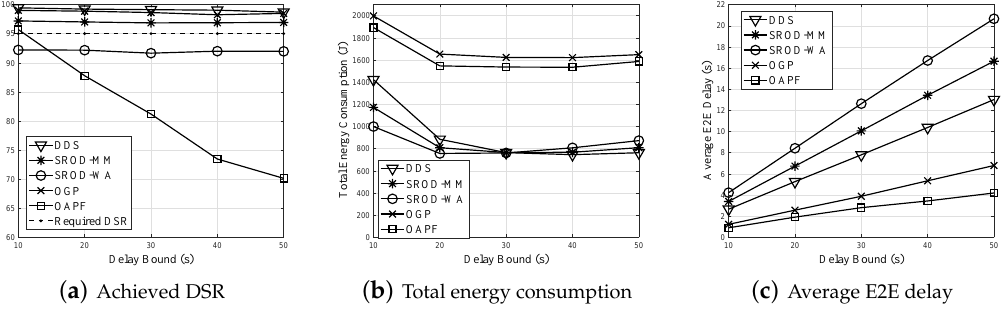
Figure 4. Effects of delay bound on the achieved deadline success ration (DSR), total energy consumption in the network, and average end-to-end (E2E) delay, with required DSR γ = 95% and the event rate at 0.5